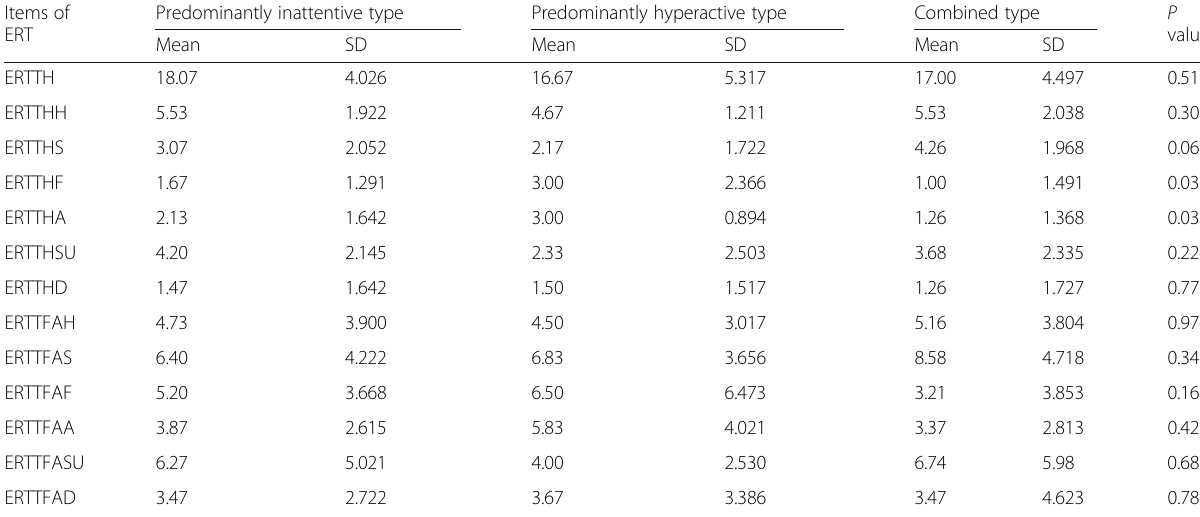
Table 3 Comparison of the mean scores of total hits (correct response) and total false alarm (error in detection) of each emotion separately between different subtypes of ADHD